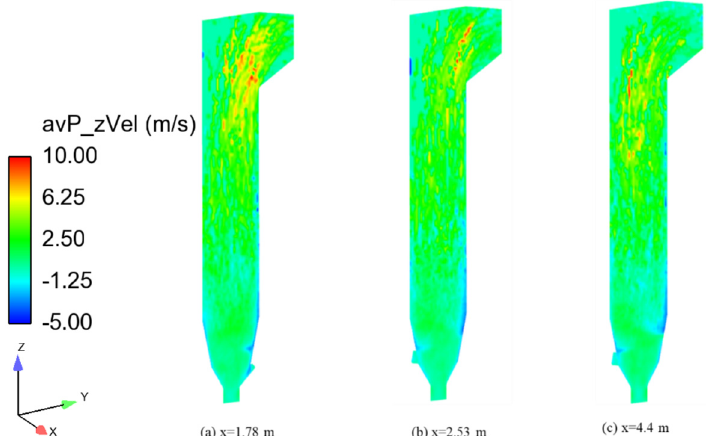
Figure 4. Contours of particles axial velocity at different vertical sections in Case 1 (( a ) − returning port; ( b ) − secondary air port; ( c ) − fuel-feeding port).